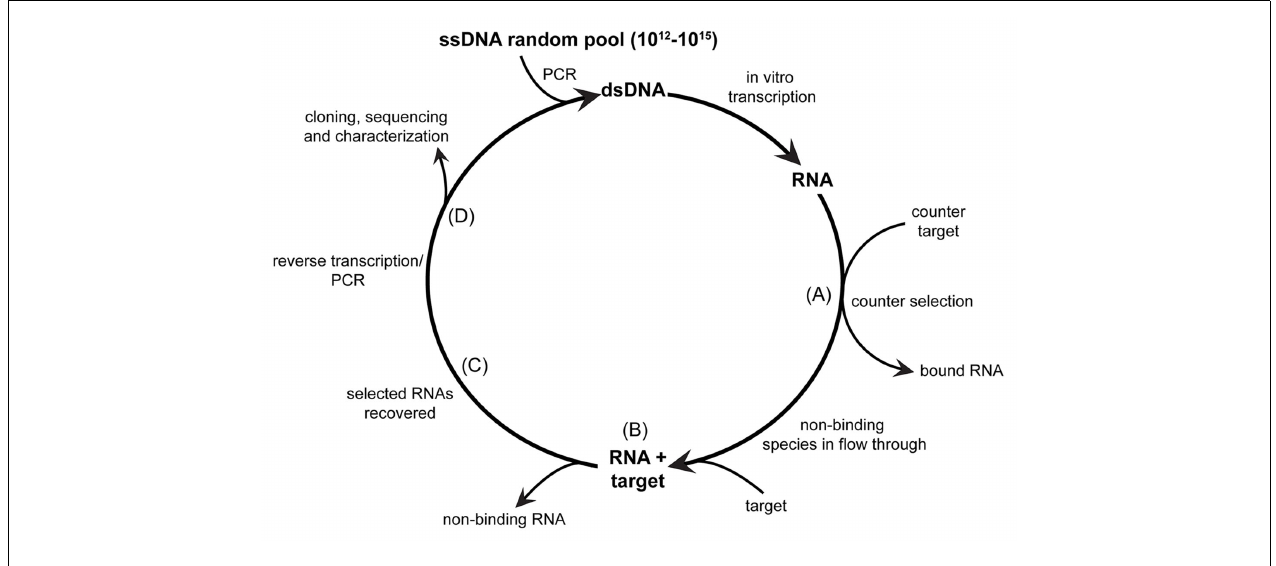
reverse transcribed, and amplified by PCR. (D)The resulting RNA pool is subjected to another round of SELEX for enrichment or cloned and